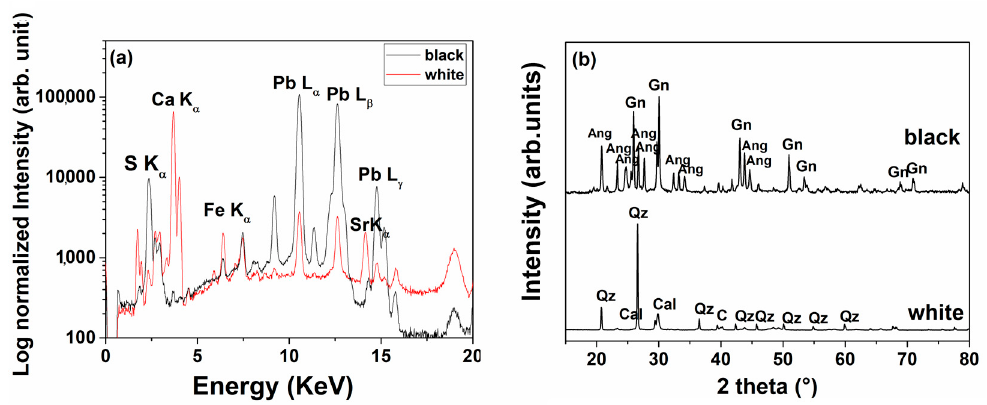
Figure 9. p XRF spectra ( a ) and XRD patterns ( b ) (Gn = galena, Ang = anglesite, Cal = calcite, Qz = quartz) of the powdered layers.